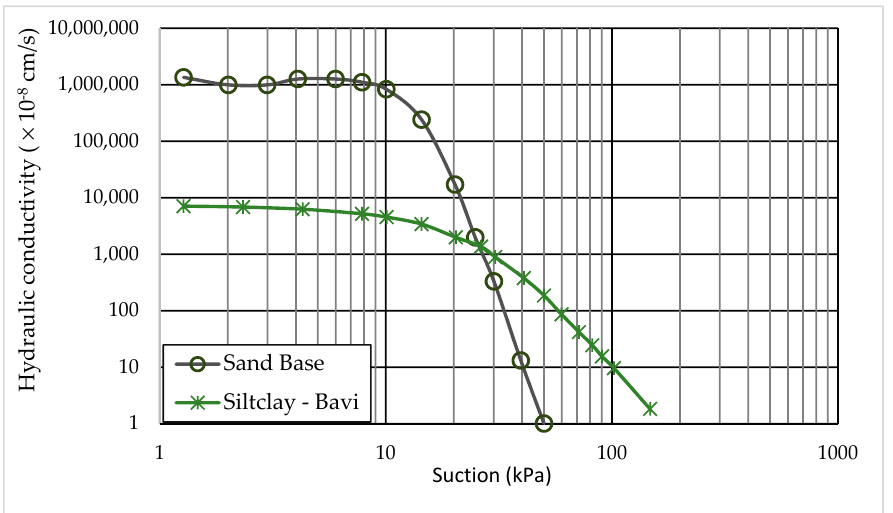
Figure 3. The unsaturated hydraulic conductivity curves. Table 1. Soil properties used in riverbank stability analysis in Ba Vi